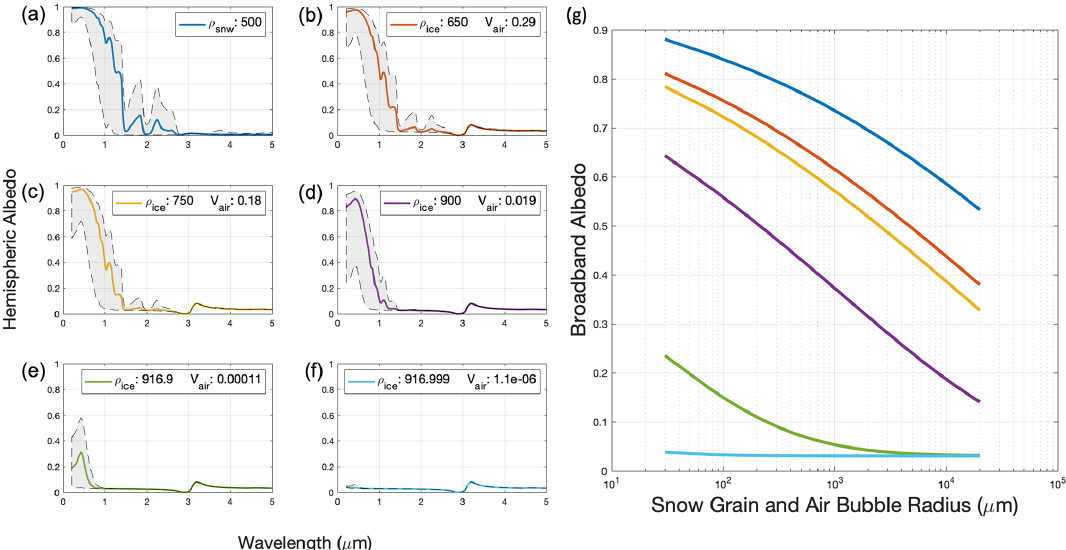
Figure 3. (a–f) Spectral albedo as a function of wavelength, snow or ice density, and the ice volume fraction of air. Shading indicates the full range of clean snow or ice albedo as a function of snow grain or air bubble radius, and the spectral albedo for an ice grain/air bubble with an effective radius of 180µm is indicated by the colored line. Panel (a) is a snow layer; all the other panels are ice layers. The radius ranges from 30µm (the highest albedo curves) to 20000µm (the lowest albedo curve). The model parameters are included in Table A1. (g) Broadband albedo (BBA) as a function of grain size (log scale). Each BBA and SSA corresponds to a spectral curve in panels (a) – (f) with a particular snow grain or air bubble